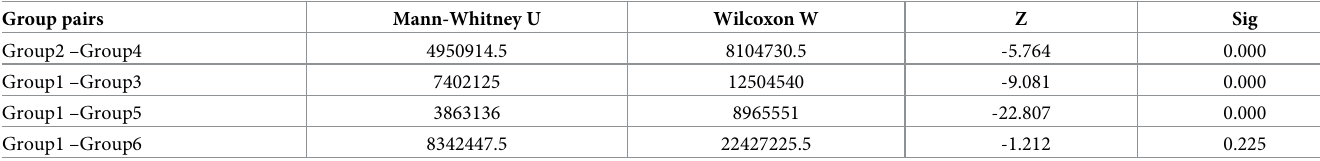
Table 3. Significance test for each comparison